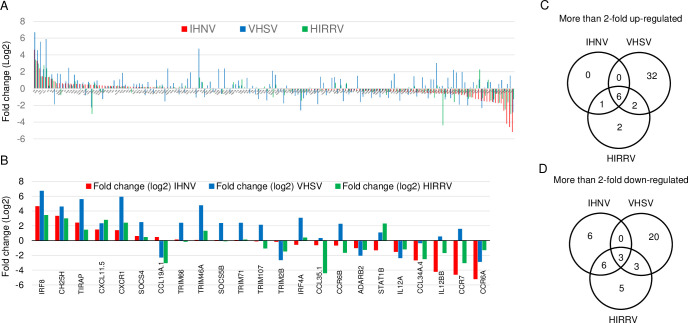
Effect of novirhabdovirus infection on host gene expression of HINAE cells.(A) Fold changes of (A) 170 innate immune response genes and (B) 23 innate immune response genes with more than 4-fold change in HINAE cells at 24 h after 1 multiplicity of infection (MOI) with IHNV, VHSV, or HIRRV. S5 Table contains detailed information about gene name and fold change value for each gene. (C & D) Numbers in the Venn diagrams (http://bioinfogp.cnb.csic.es/tools/venny/index.html) represent the number of cellular genes with more than two-fold (C) up-regulated and (D) down-regulated in IHNV-, VHSV-, and HIRRV-infected cells at 24 h post-infection.